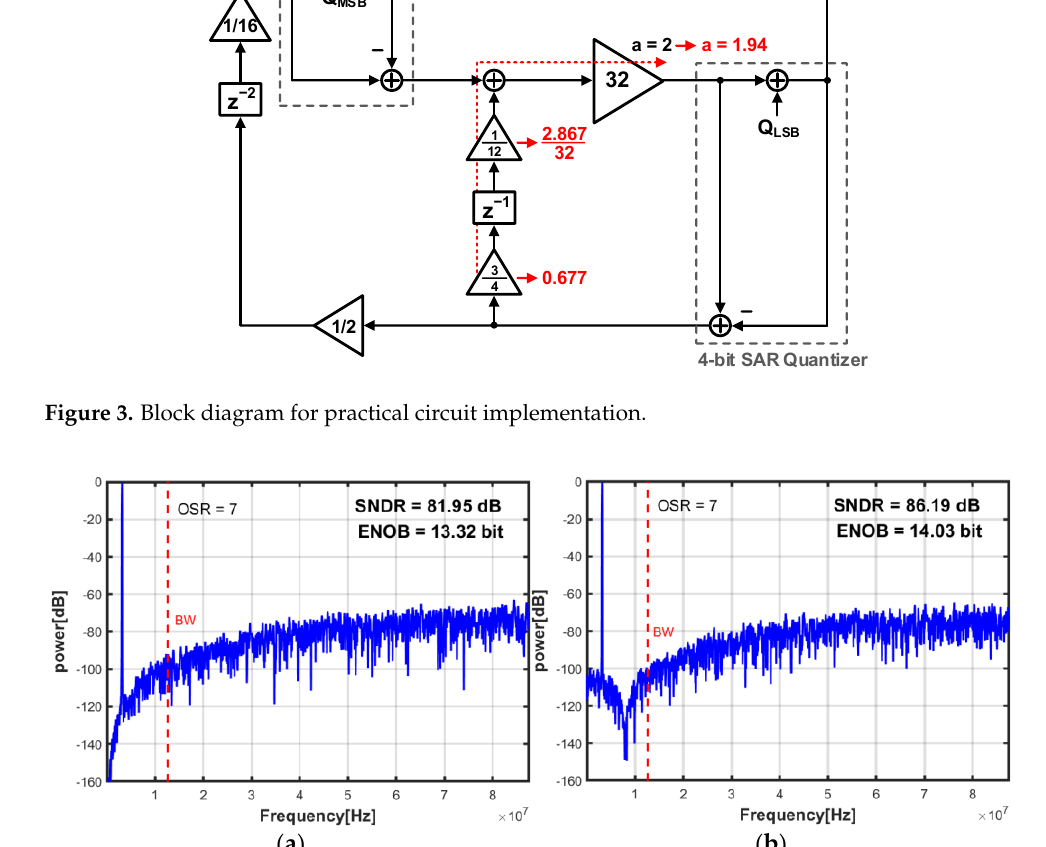
Figure 4. Power spectral density ( a ), with zero located at 1 ( b ) with zero optimization.